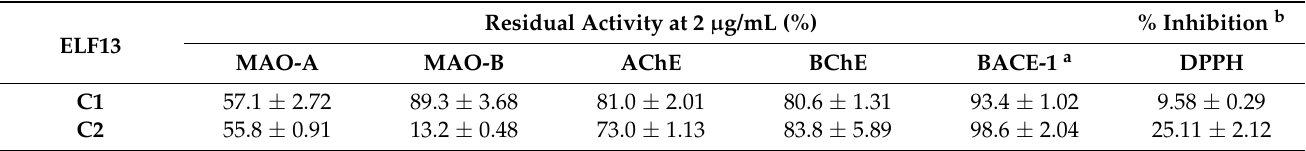
Figure 1. Residual activities of the ELF13 extract and eight fractions from primary PTLC. The com- pound was separated with the first solvent (ethyl acetate:toluene = 1:9, v / v ). The activity of the compound was measured at 20 µg/mL. Table 3. Inhibitory activities for the enzymes of two isolated compounds.